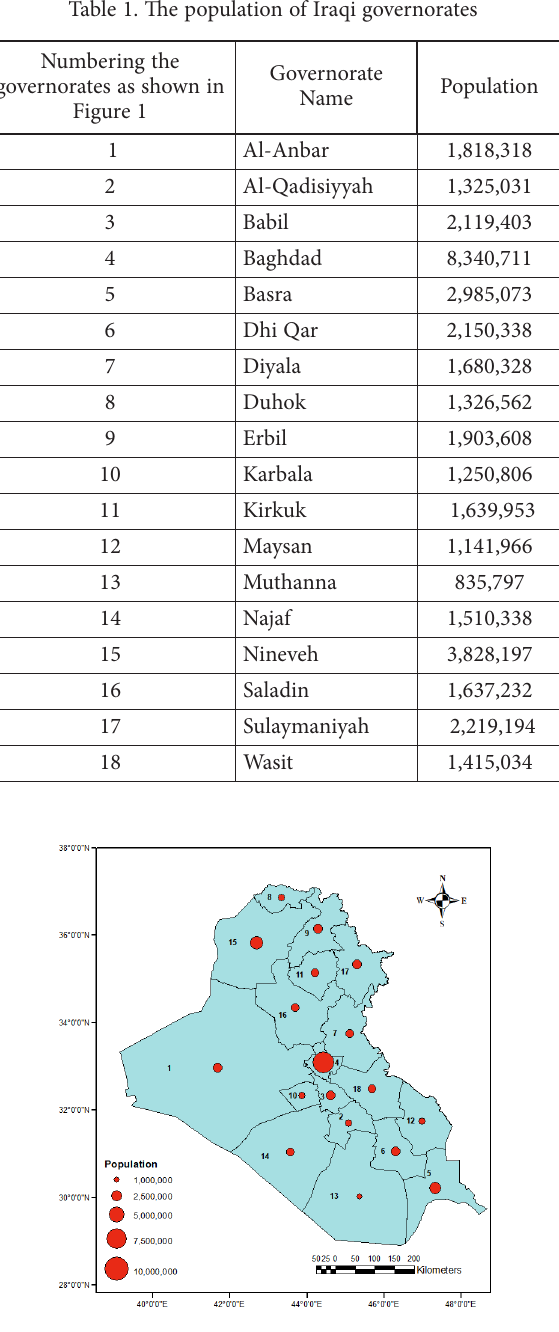
Figure 3. The distribution and the population of 18